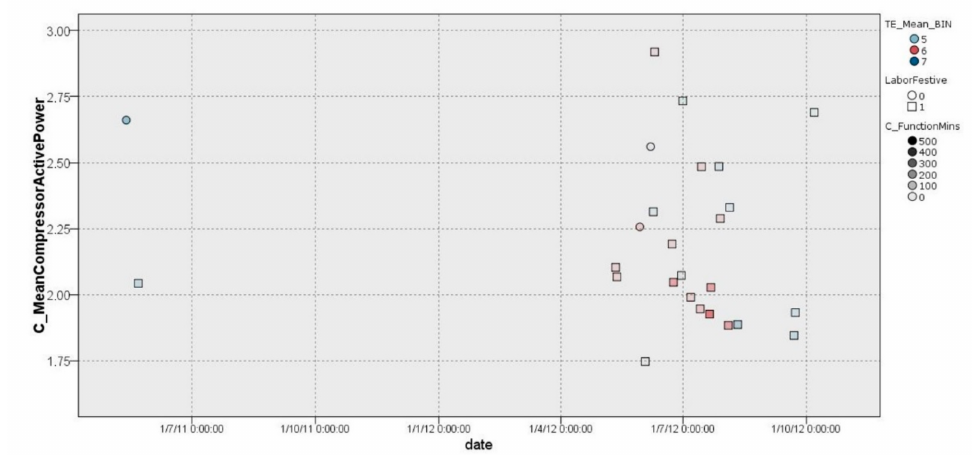
Figure 8. Graphical representation of distribution of cluster